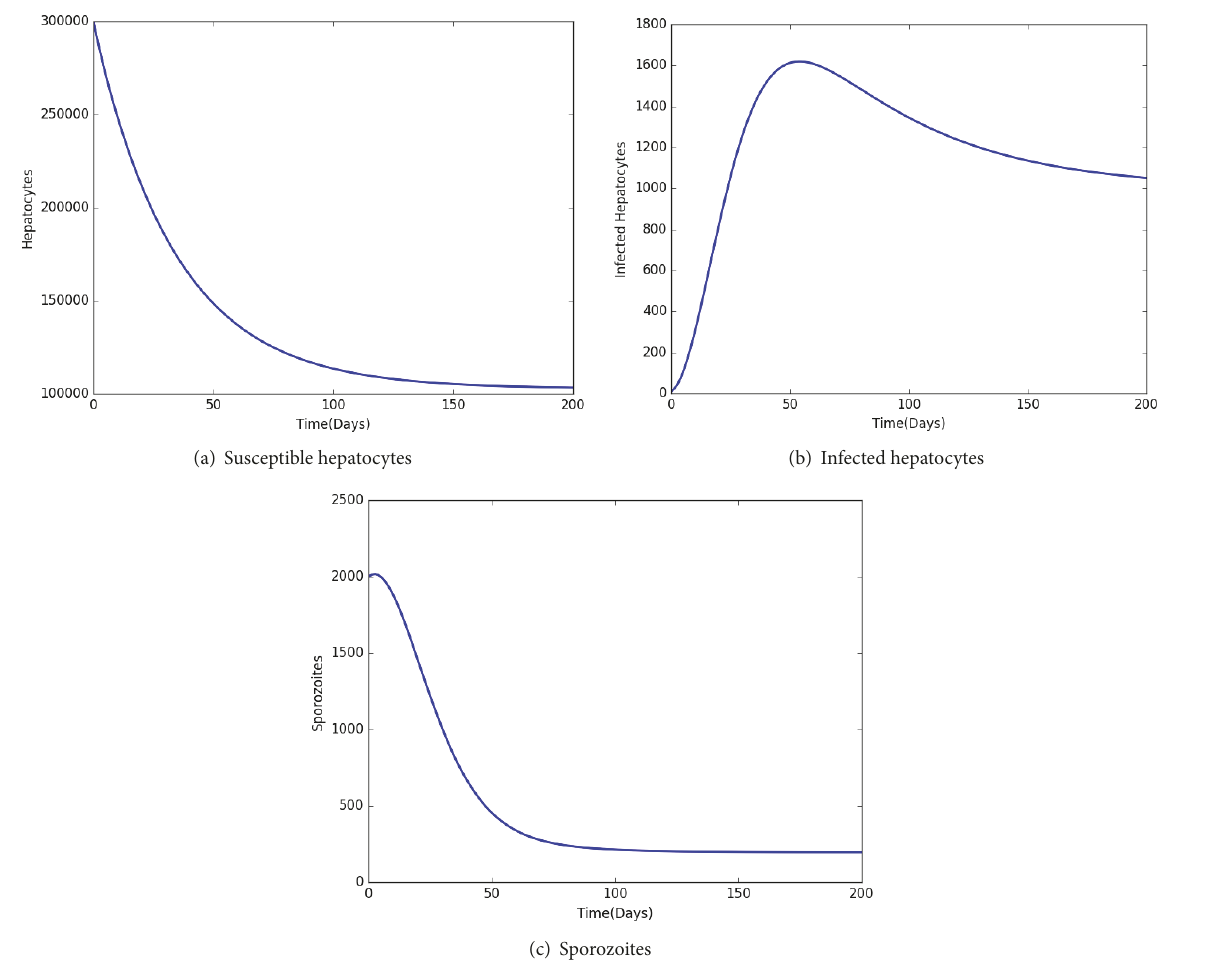
Figure 4: Graphs showing population dynamics of the liver hepatocytes and malaria sporozoites when 𝑅 0 = 1.58690 > 1 . Used parameter values can be found in Table 3 with the chosen initial conditions described by 𝐻0 = 300000 , 𝐻 𝑋 0 = 10 , 𝑅0 = 500000 , 𝑅 𝑋 0 = 10 , 𝑍0 = 10 , 𝑆0 = 2000 , and 𝑀 = 20